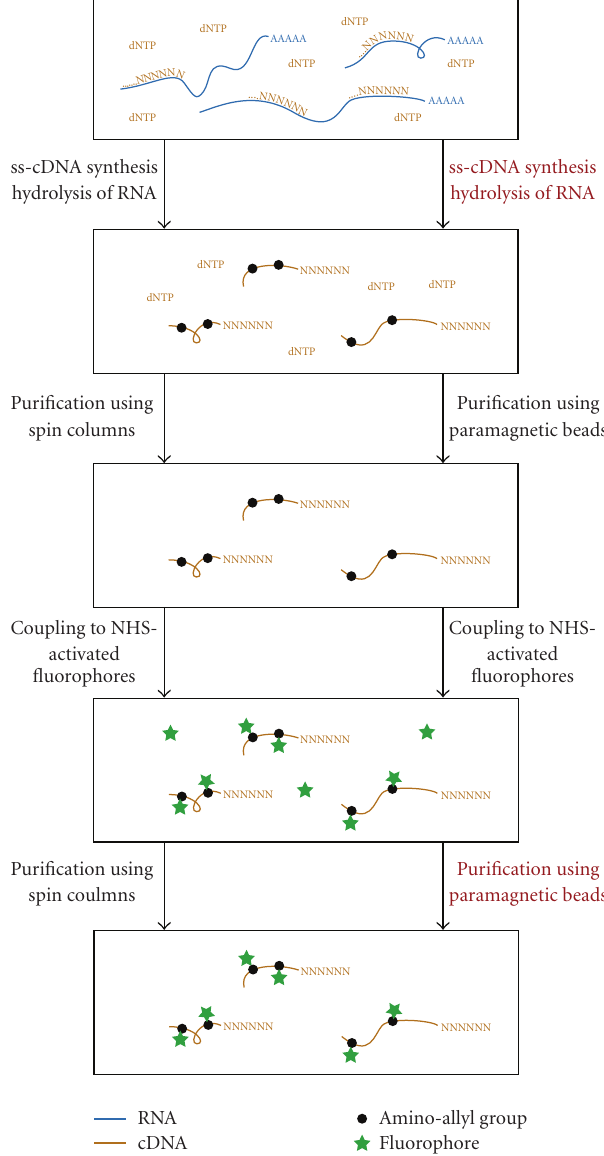
Figure 1: Outline of the cDNA synthesis and labelling workflow. The manual workflow is presented on the left and the automated work flow on the right. Di ff erences between the manual and automated approaches are highlighted in red, and include the purification steps and neutralization after RNA